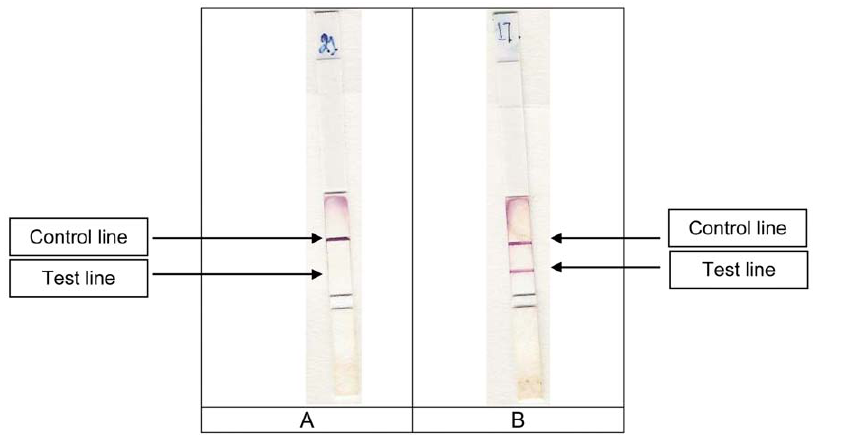
Figure 1. Two dispsticks showing typical negative (A) and positive (B) results after being kept for 10 minutes in bacterial cultures (1) , watery or dysenteric stool samples. 1 The specificity was assessed using pure cultures of the following bacterial strains: S. flexneri serotypes 1a (strain 082429), 1b (strain 085052), 2a (strain 083766), 2b (strain 082831), 3a (strain 084963), 3b (strain 083638), 4 (strain 075519), 4c (strain 08 3649), 6 var Herforshire (strain 083400), 6 var Manchester (strain 080654), Y (strain 075876) and X (strain 08 3347); S. dysenteriae serotypes 2 (strain 083092),